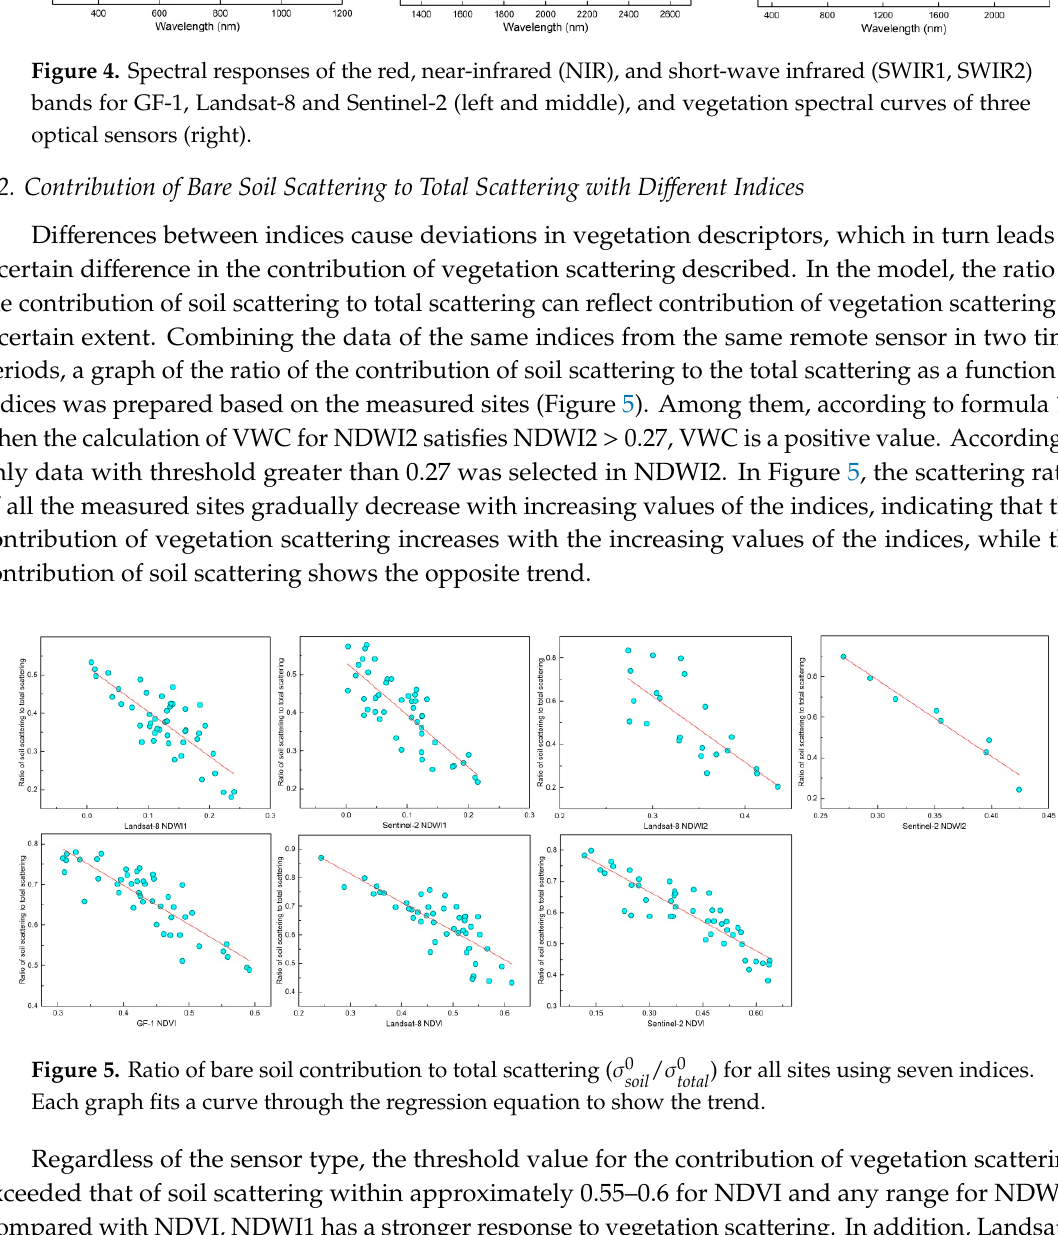
/ σ 0 ) for all sites using seven indices. soil total